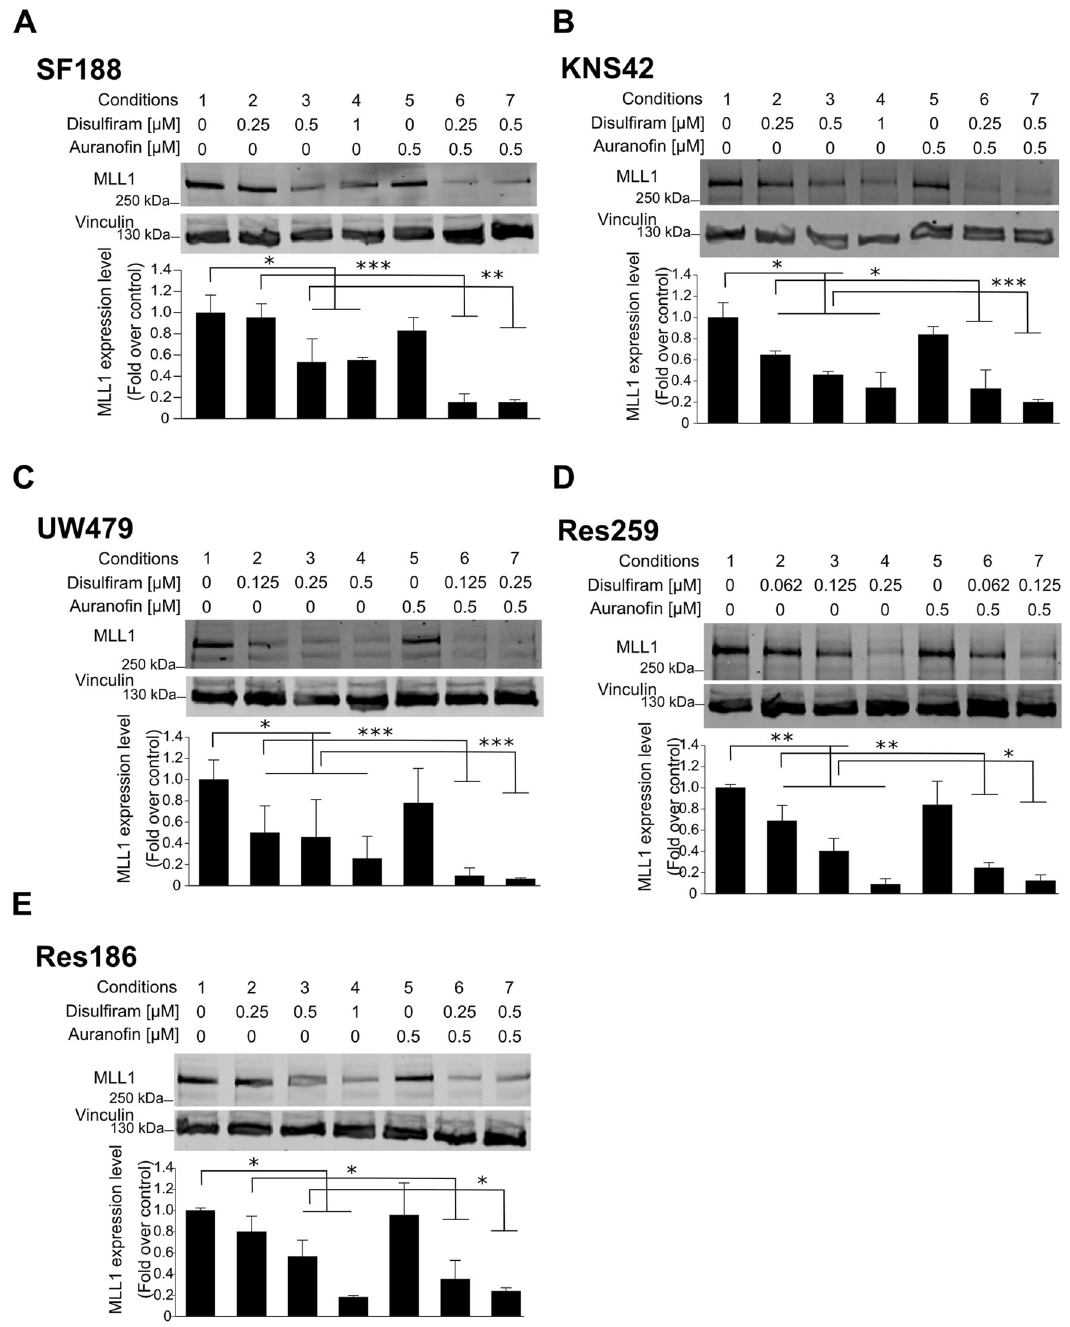
Fig. 2 Disul fi ram induces MLL degradation. A – E Top: whole-cell lysates were prepared from the indicated cell lines, cultured in the absence or presence of 0.5 mM aurano fi n with increasing concentrations of disul fi ram for 16 h. Extracts were probed with α -MLL1 antibody and α - vinculin antibody as loading control. Bottom: the graphs represent image analysis of band intensity. Data are mean ± STD; n = 3; ∗ p < 0.05, ∗∗ p < 0.01 ∗∗∗ p < 0.001; two-way analysis of variance (ANOVA) test with Bonferroni